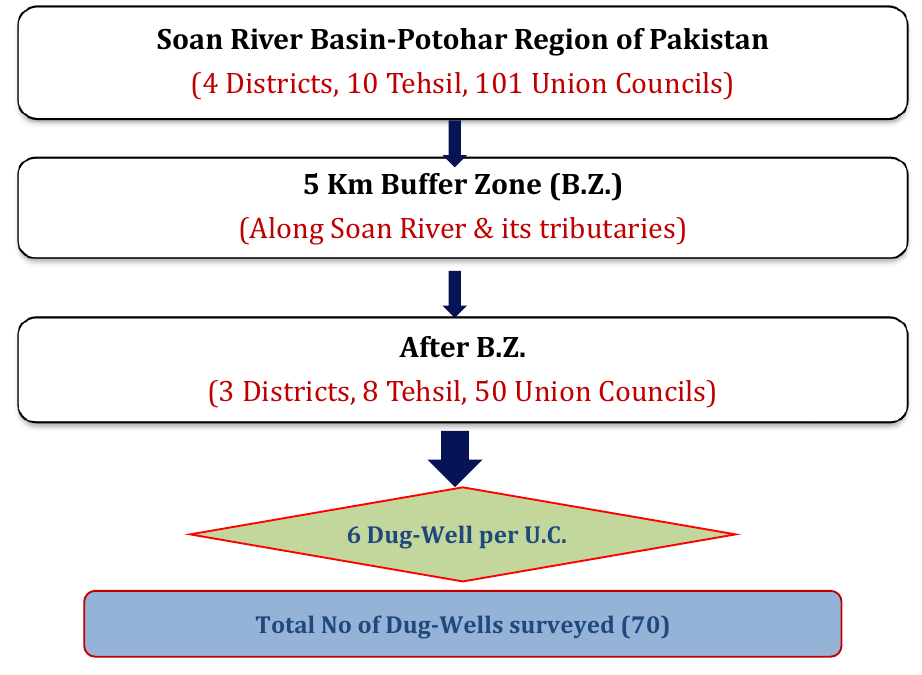
Figure 4. Conceptual flow chart of study.